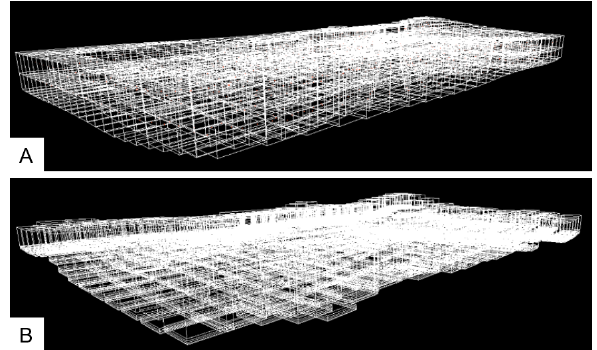
Figure 5. Visualization of the simulated climate data 3D grids; each height level is represented by a grid of 3D cells; (A) visualization of two height levels of Meso-NH data; (B) visualization of six height levels of TEB data.